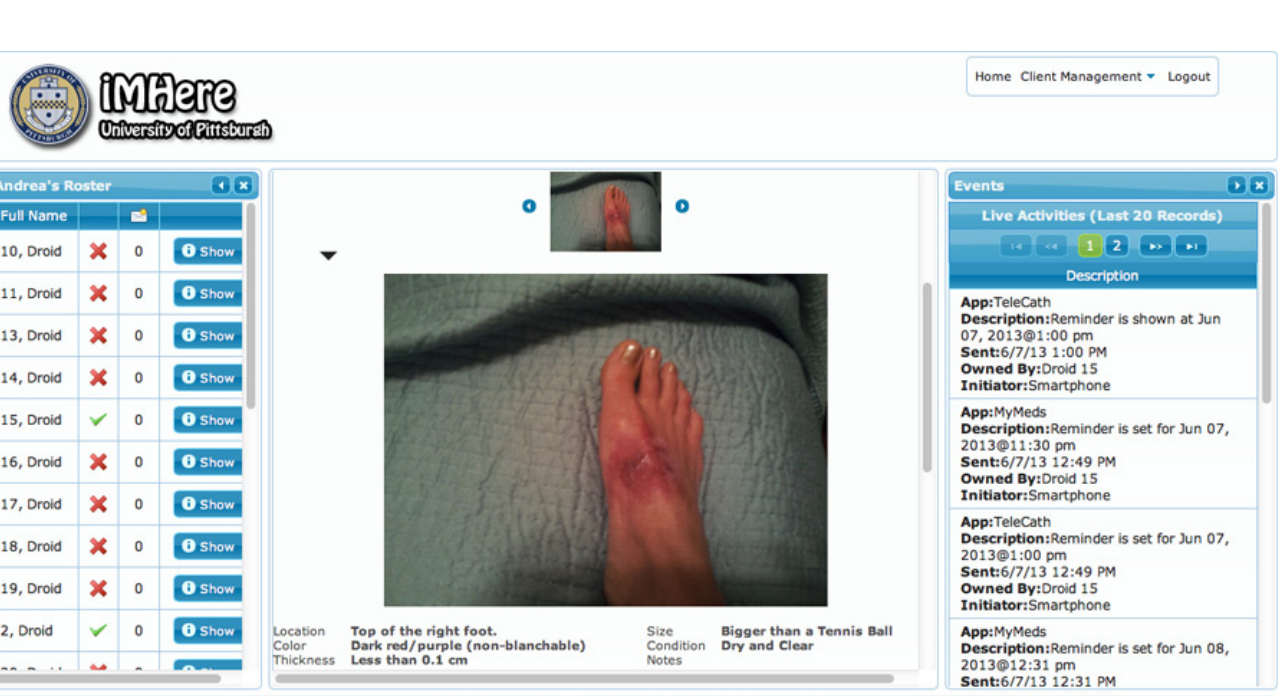
Figure 12: iMHere Clinician View of SkinCare Entry which can allow monitoring of progress in wound healing over time.